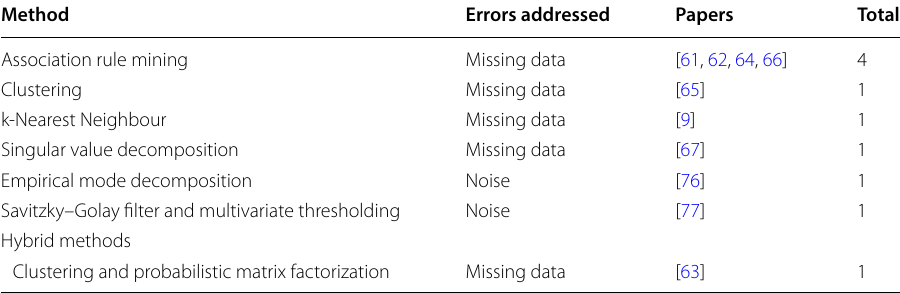
Table 4 Methods for error correction (RQ3), along with its addressed errors, respective papers, and the total number of papers that proposed that